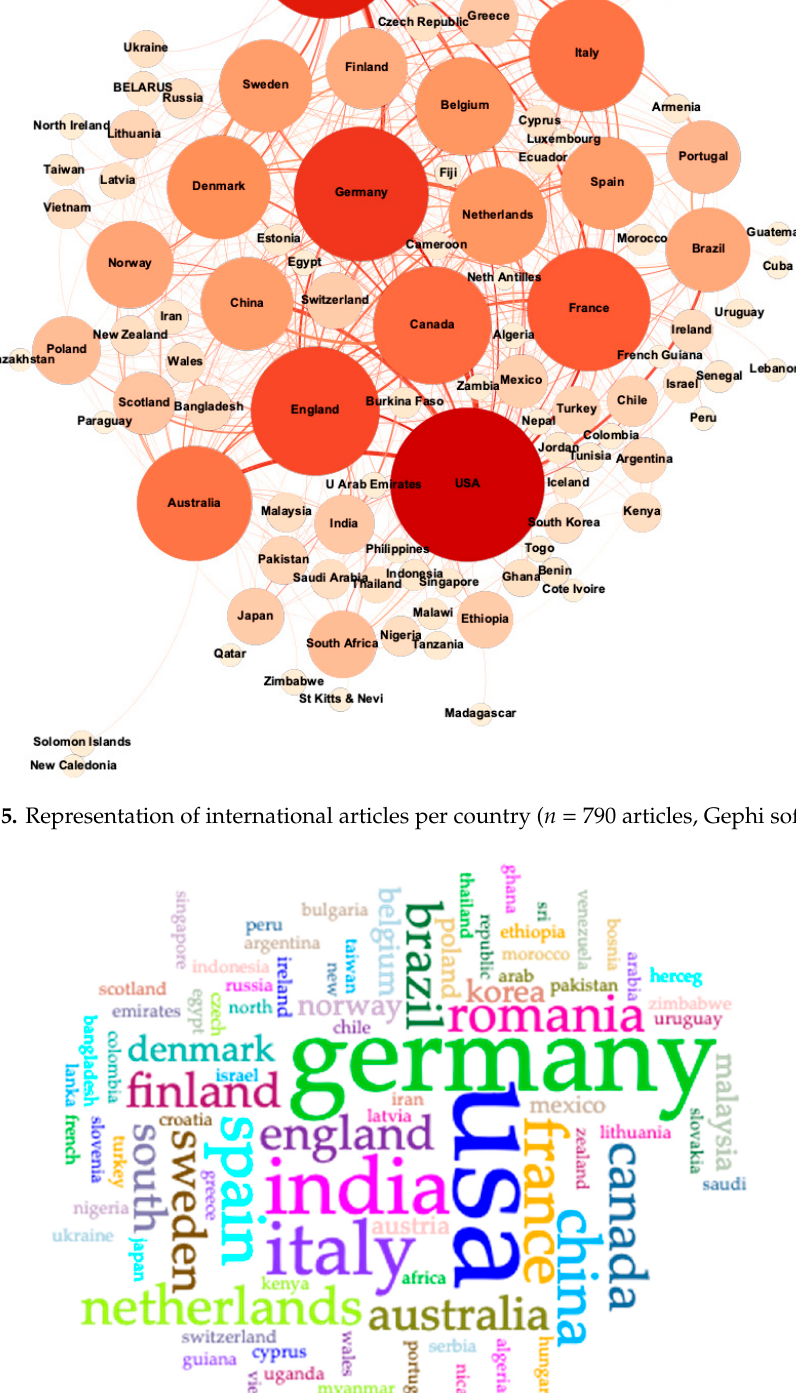
= 790 articles, Voyant Tools